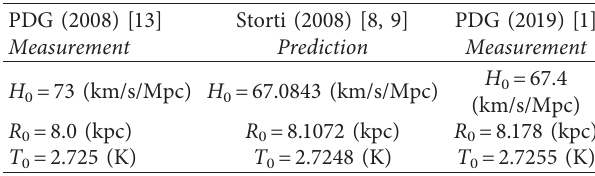
Table 4: Experimental validation of